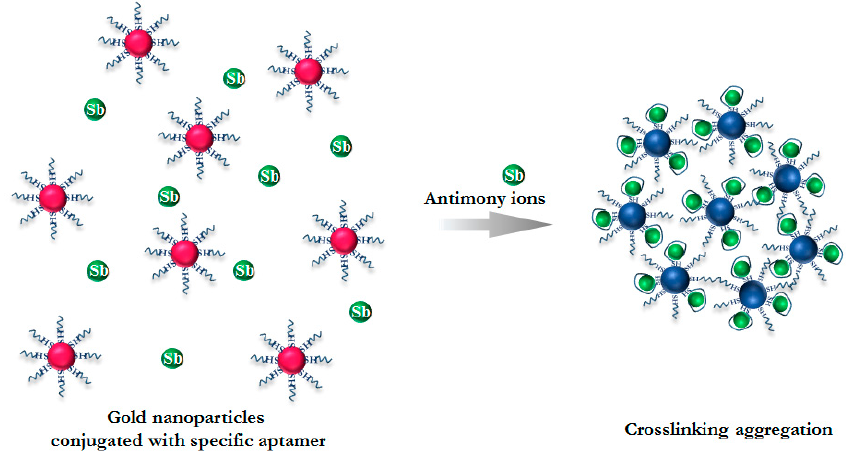
Figure 1. Principle of colorimetric determination of Sb 3 + based on aggregation of modified gold nanoparticles (GNPs).